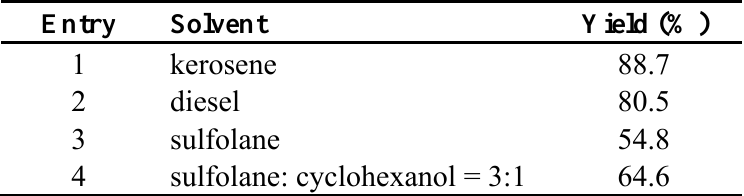
Table 1. Effect of different kinds of solvent on experimental results.